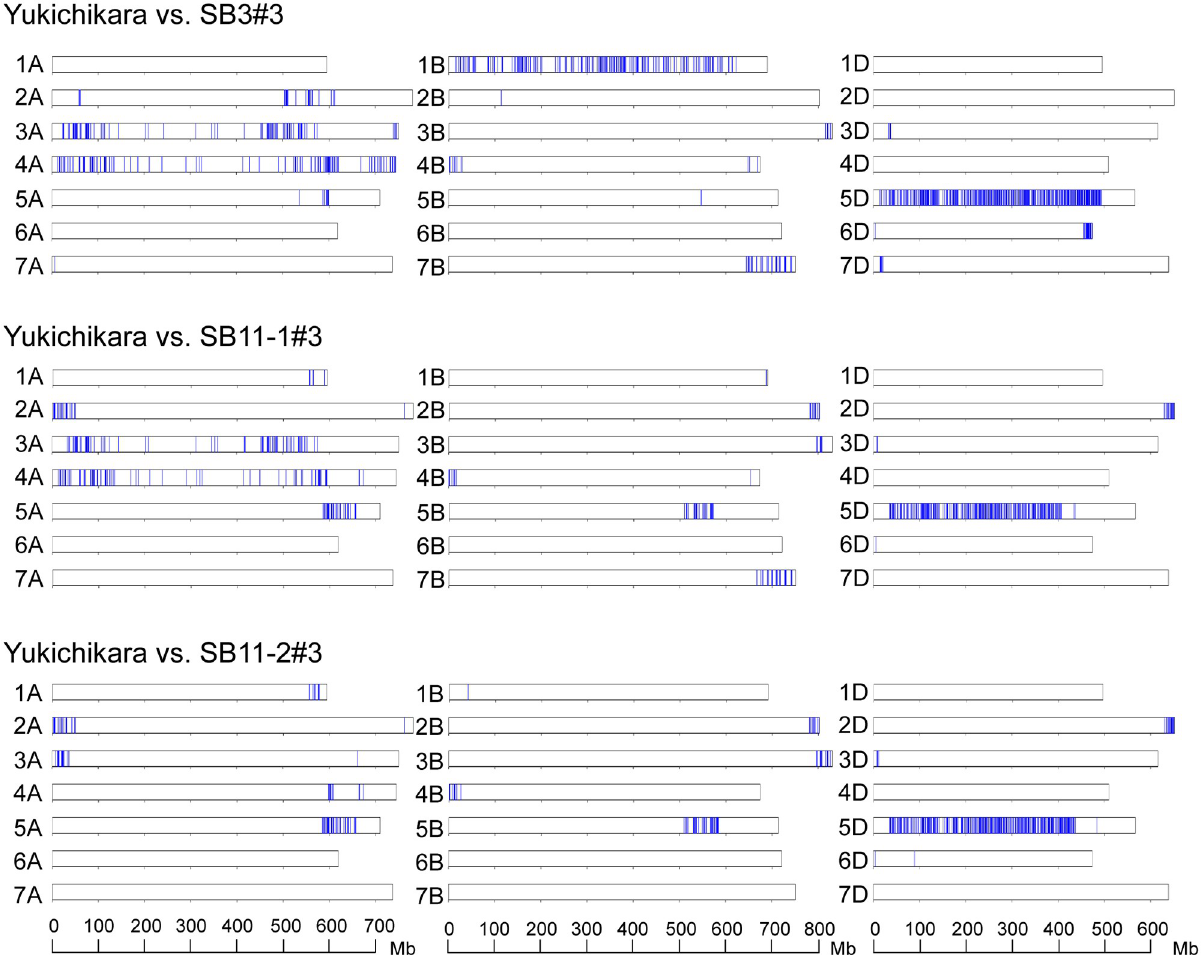
Fig 5. Genome-wide graphical genotypes of the three selected early heading lines of Yukichikara. Vertical bars (blue) indicate the SNP sites detected between the three selected lines and their backcrossed parental cultivar Yukichikara on each of the 21 wheat chromosomes.